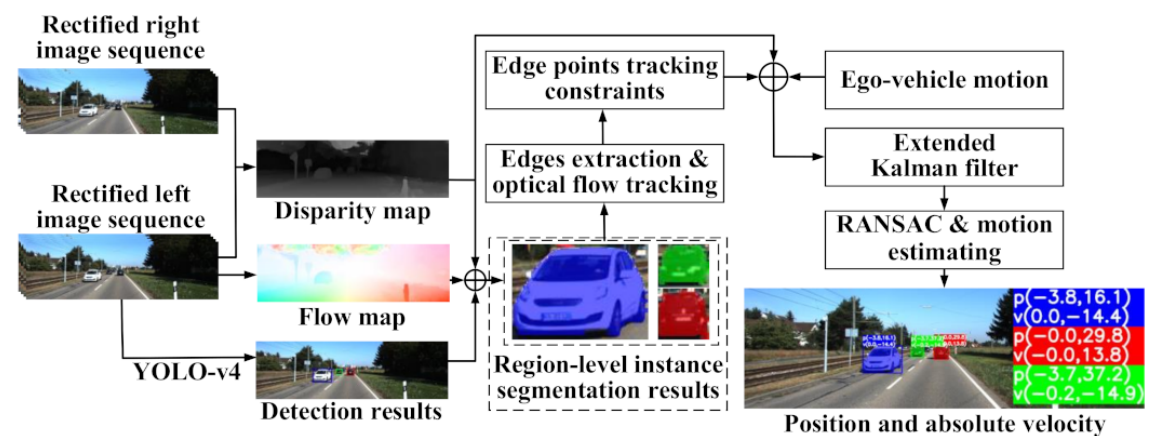
Figure 2. The framework of the proposed method. P ( , ) represents the lateral and longitudinal distances of objects in the camera coordinates, and V ( , ) denotes the lateral and longitudinal absolute